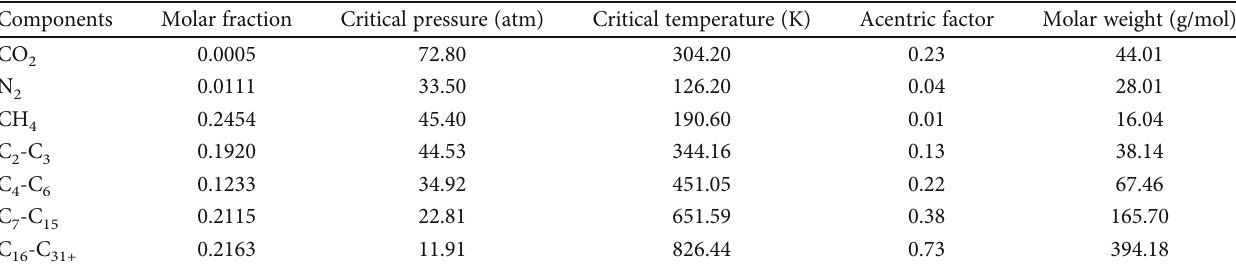
Figure 2: Schematic diagram of the slim tube experiment device. Table 3: Properties of pseudocomponents of the oil